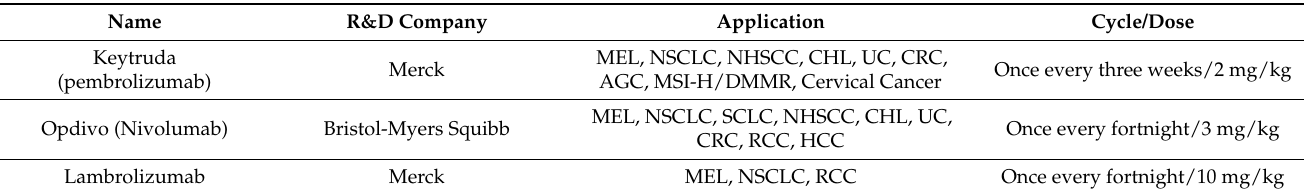
Table 1. PD-1/PD-L1